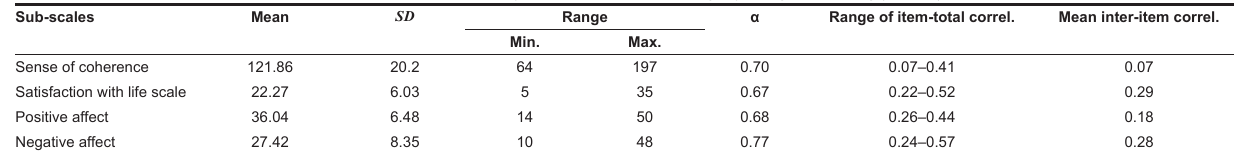
TABLE 1 Means, variances and reliability indices for scales measuring psychological wellbeing ( N = 738)